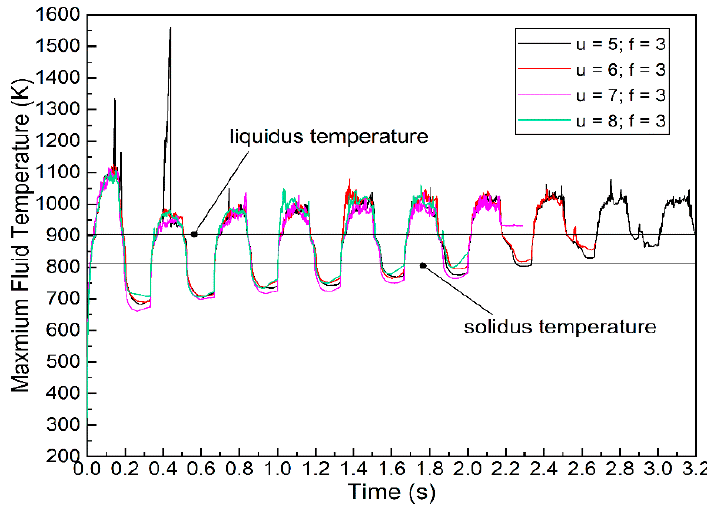
Figure 10. Variations of maximum fluid temperature with welding speed and time.